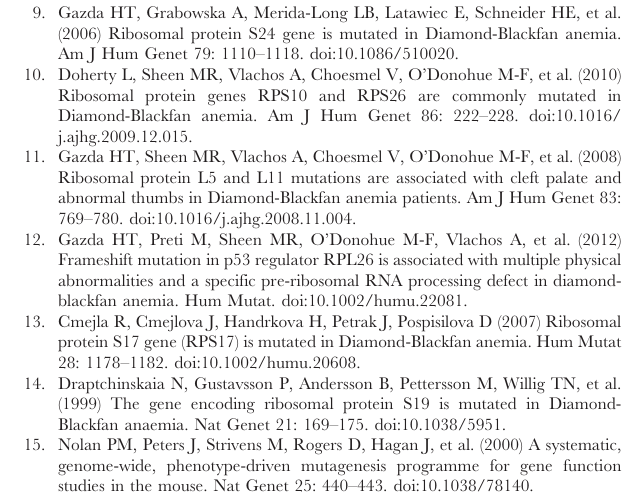
Table S4 Surviving numbers of postnatal offspring from an haploinsufficiency restores Rps7 viability. (PDF) Video S1 MRM-based reconstructions of Rps7 + / + brain. Regions of late gestation (E18.5) brain defined by manual segmentation of MRM images for volumetric calculations are shown as follows: olfactory bulbs (light gray), lateral ventricles (lime green), cortex (red), septum (yellow), striatum (dark blue), 4 th ventricle (charcoal gray), hippocampus (purple), thalamus (cyan), colliculi (orange), cerebellum (dark green). (MOV) Video S2 MRM-based reconstructions of Rps7 Zma/ + brain. Regions of late gestation (E18.5) brain defined by manual segmentation of MRM images for volumetric calculations are shown as follows: olfactory bulbs (light gray), lateral ventricles (lime green), cortex (red), septum (yellow), striatum (dark blue), 4 th ventricle (charcoal gray), hippocampus (purple), thalamus (cyan), colliculi (orange), cerebellum (dark green).